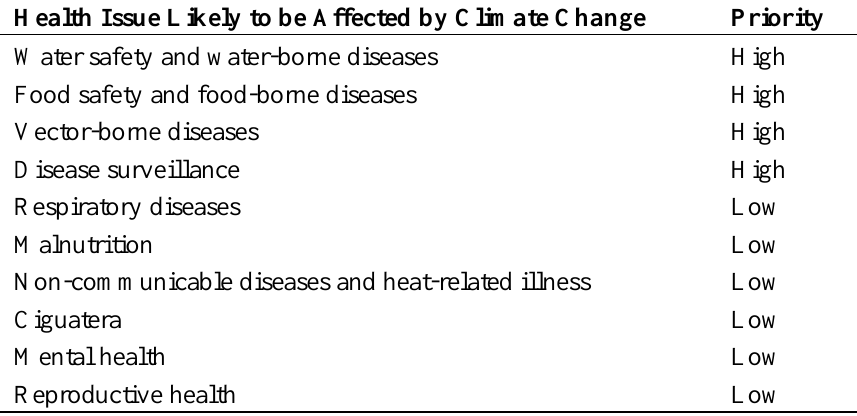
Table 3. Climate change and health adaptation priorities in